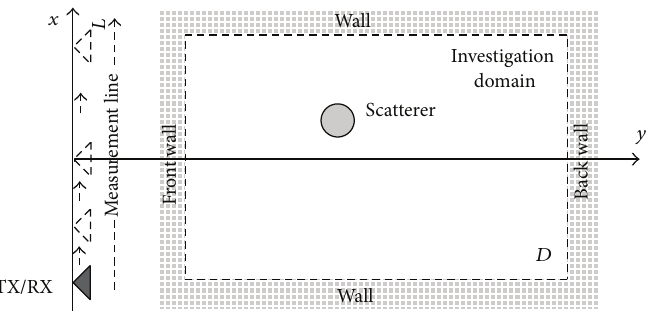
Figure 3: Schematic of through-wall geometry.